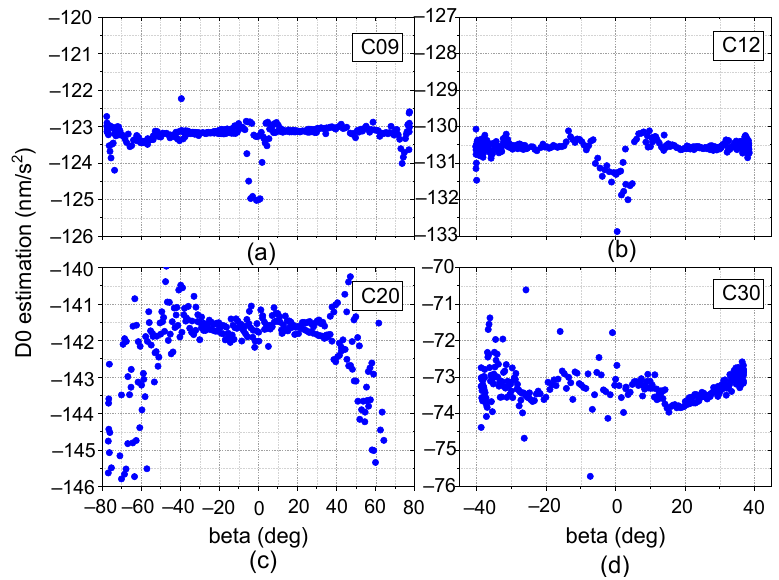
Figure 3. Comparison of the D0 variation between the BeiDou-2 and BeiDou-3 satellites. ( a ), ( b ), ( c ), and ( d ) are the D0 variation of C09, C12, C20, and C30, respectively.